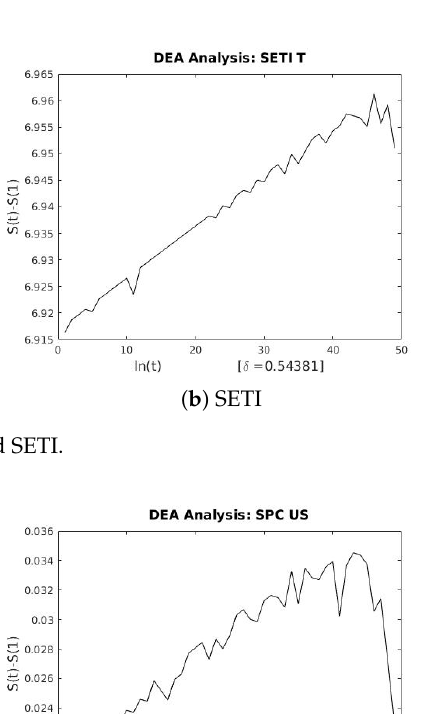
Figure A4. DFA for SP500 and SPC USA.